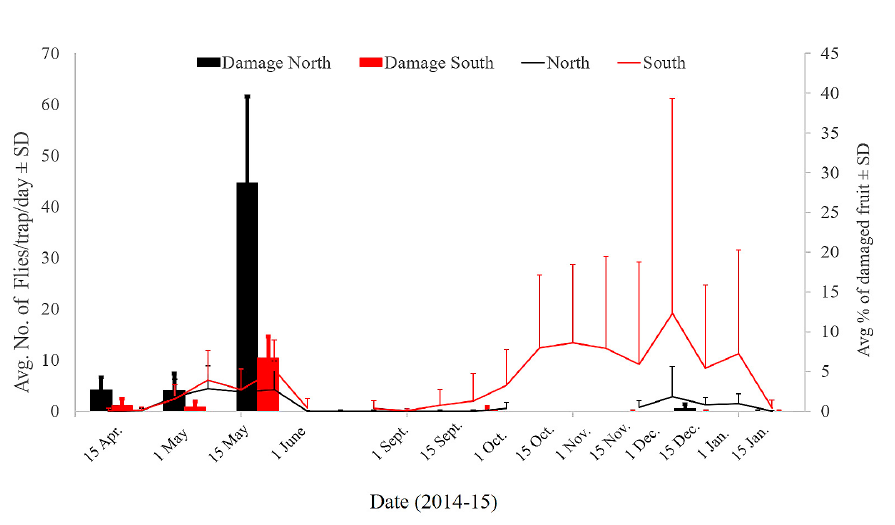
Figure 7. Map of Ethiopian fruit fly trapping-level in Rimi ® yellow sticky boards (dots) and percent of infested fruit produced in plastic greenhouses in the northern and southern melon growing areas of Ein Yahav during the week of 8–15 May 2014.